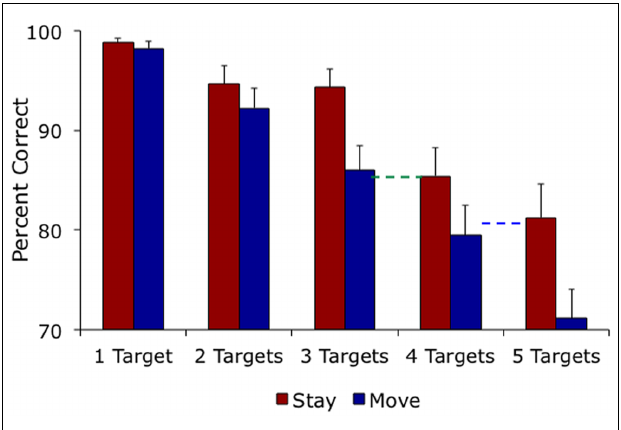
FIGURE 1 | Mean percentage correct in the tracking